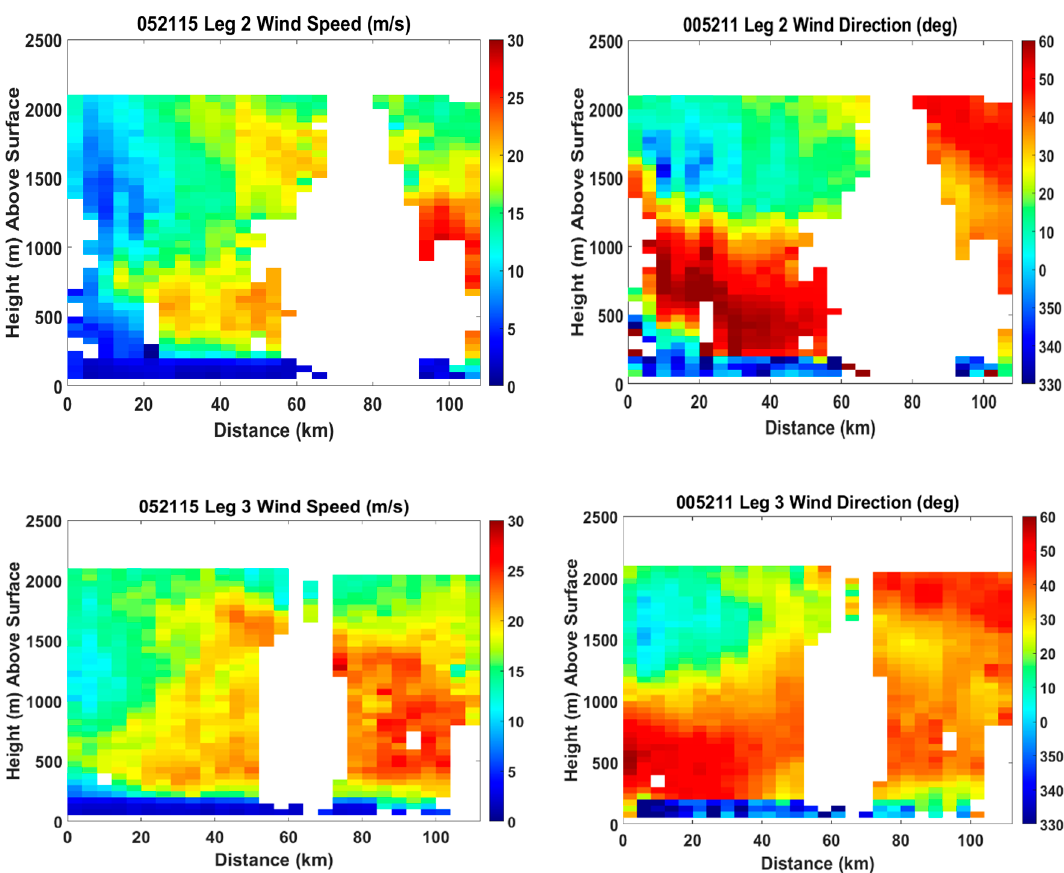
Figure 7. DAWN wind speed ( left ) and wind direction ( right ) cross section during the three NW–SE legs from turn to turn: Leg 1( top ), Leg 2 ( middle ) and Leg 3 ( bottom ) on 21 May 2015.